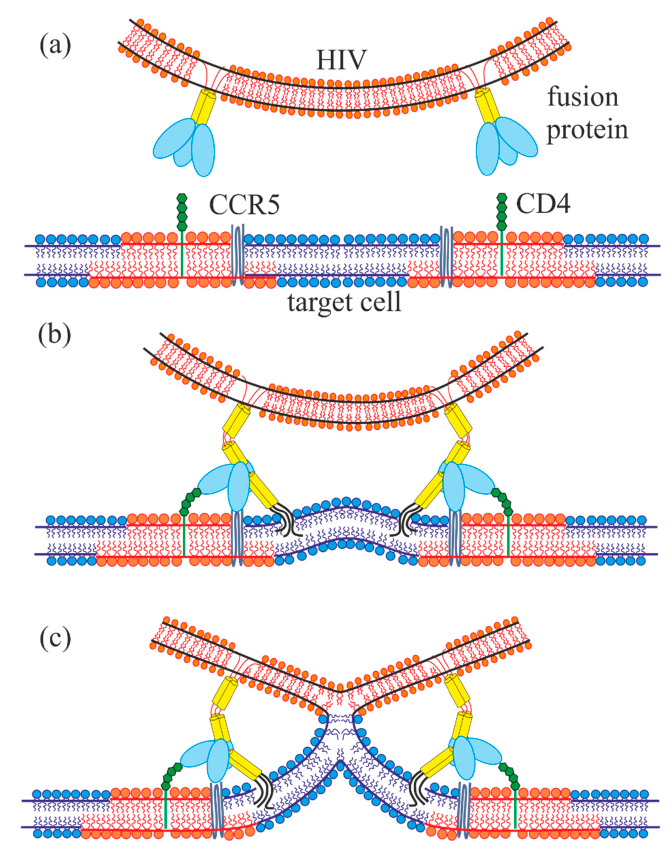
Figure 1. Schematic representation of the initial stage of T-cell infection by HIV. ( a ) Viral membrane in the vicinity of the target cell membrane; the target cell membrane consists of lipids of raft (highlighted in red) and non-raft (shown in blue) phases. ( b ) Interaction of fusion proteins with CD4 receptors (green) and CCR5 co-receptors (midnight blue) on the cell surface accompanied by conformational transitions of fusion proteins and incorporation of fusion peptides (shown in black) into the cellular membrane. ( c ) Formation of stalk—a structure, in which the contact monolayers of membranes already fused, while the distal ones have not